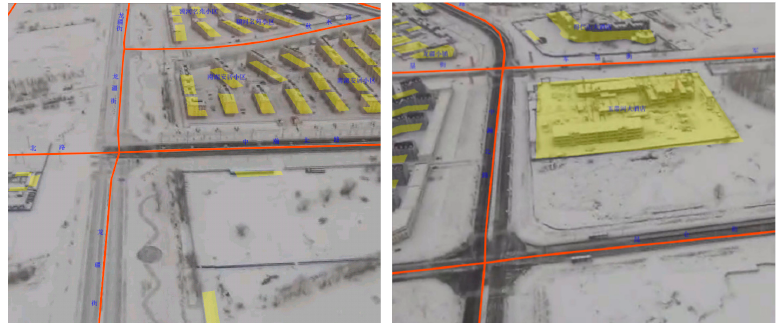
Figure 9. The results of the geo-registration process, the models of the roads and the buildings are matched well with the objects in the real image. ( Left ) The geo-registration process of roads and multiple buildings. ( Right ) The geo-registration process of separate large building.